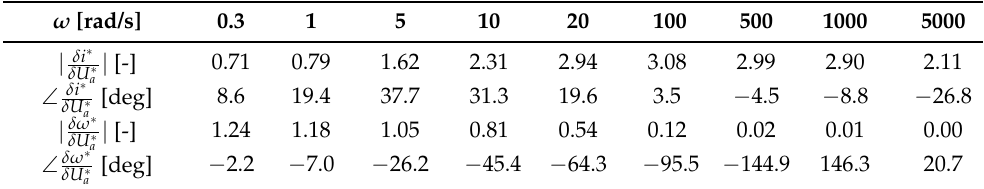
Table 2. Experimental FRD based on single sinusoidal testing, followed by processing with the correlation